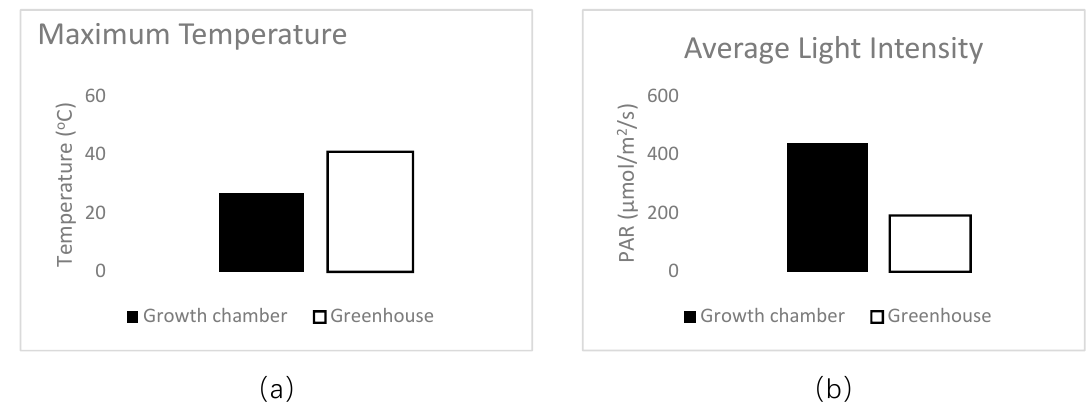
Figure A1. There were discrepancies in temperature and light conditions between the coarse assay and micronutrient experiments. ( a ). The coarse assay plants in the greenhouse experienced less light (192 µ mol / m 2 / s) and higher temperatures (up to 41 ◦ C) than their micronutrient counterparts in the growth chambers (440 µ mol / m 2 / s, 27 ◦ C). The temperature values are single point maximums and the light intensity for the growth chamber was constant based on 3 measurements during the experiment. ( b ). The light intensity for the greenhouse is an average of 3 measurements made between 11 a.m. and 12 p.m. Di ff erences in stress conditions between the two experiments could help explain their inconsistent